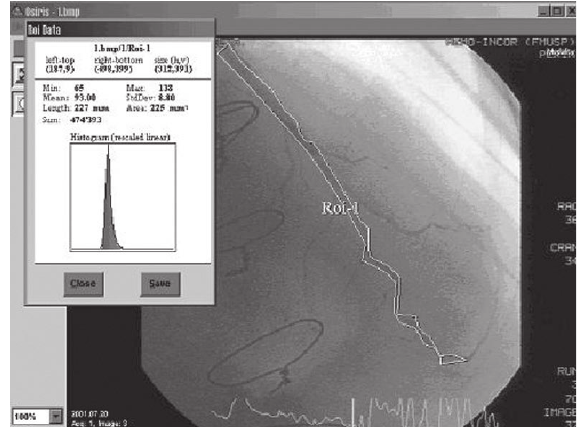
Fig. 1 - Delimitação da área coronariana do ramo interventricular anterior, anexo histograma sobre a área de interesse portanto, a 4,66 mm. As medidas foram realizadas no plano ortogonal mais adequado. A delimitação da área de interesse foi feita pela demarcação automática. Quanto à correção das distorções, sobreposições de imagens foram feitas